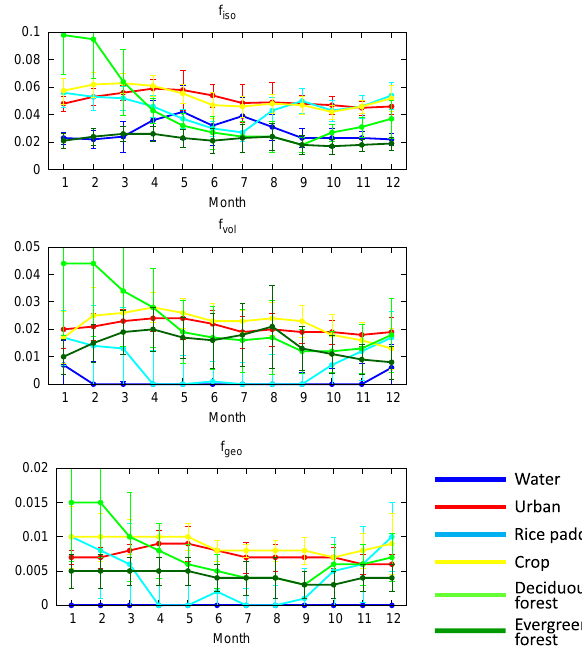
Figure 5. Monthly averages of the MODIS BRDF parameters, f iso , Fig. 5. Monthly averages of the MODIS BRDF parameters, f iso , f vol and f geo for water (blue), urban (red), rice f vol , and f geo for water (blue), urban (red), rice paddy (light blue), crop (yellow), deciduous forest (light green), and evergreen forest paddy (light blue), crop (yellow), deciduous forest (light green) and evergreen forest (green). The land cover (green). The land cover type is derived from type is derived by AVNIR-2.